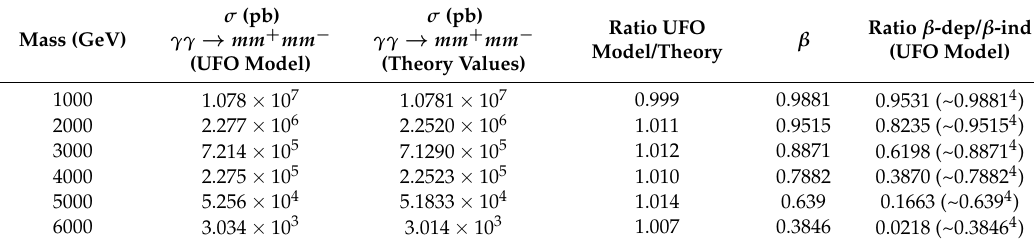
Table 6. The cross-section for the spin 1 monopole as obtained by the theory and the M AD G RAPH UFO model for the β -dependent coupling constant, when no PDF was used and the center-of-mass energy is 13 TeV. The fourth column shows the ratio of the cross-sections of UFO model to that of the theoretical prediction. The ratios, being very close to 1, suggest excellent agreement between the theory and the M AD G RAPH model. Here, the sixth column shows the ratio of cross-sections as obtained by the UFO model for β -dependent coupling to β -independent coupling (shown in Table 5). This ratio varies as β 4 , as expected from the theory [10].